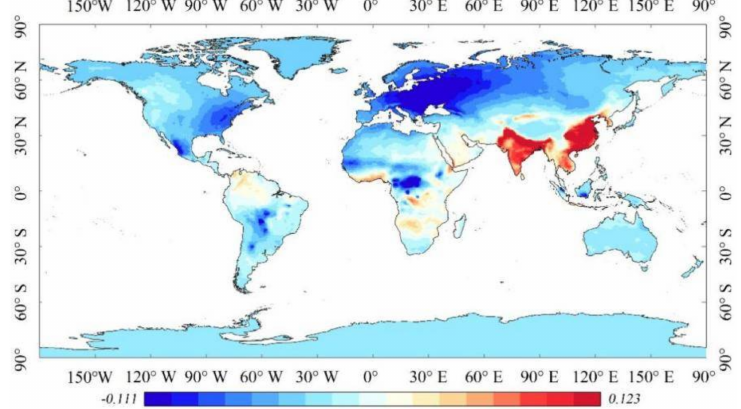
Figure 7. The Sen slope values for the global variation of AOD values during